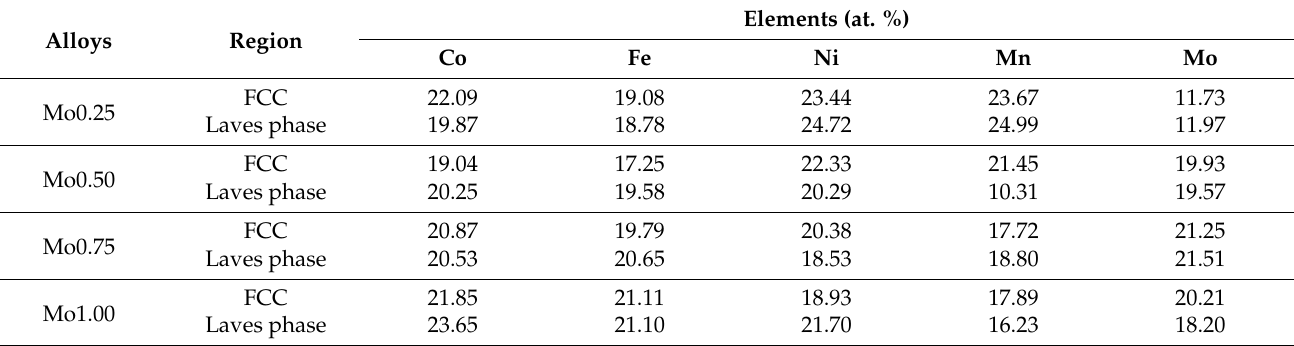
Table 1. Chemical compositions of various phases in CoFeNiMnMo x alloys in atomic percentage. Elements (at. Alloys Region